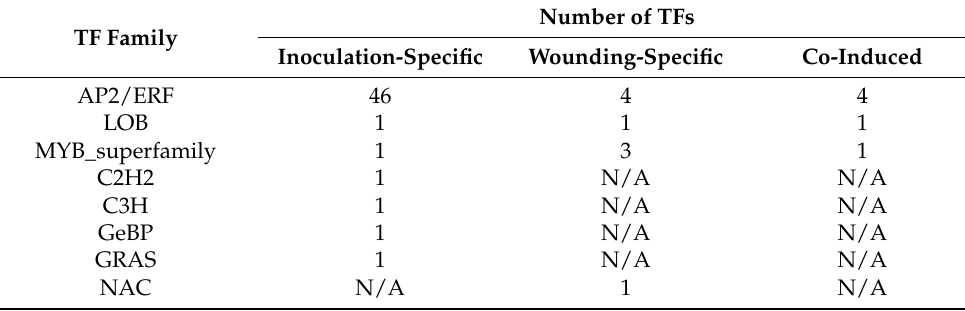
Table 2. TF statistics of DEGs under different